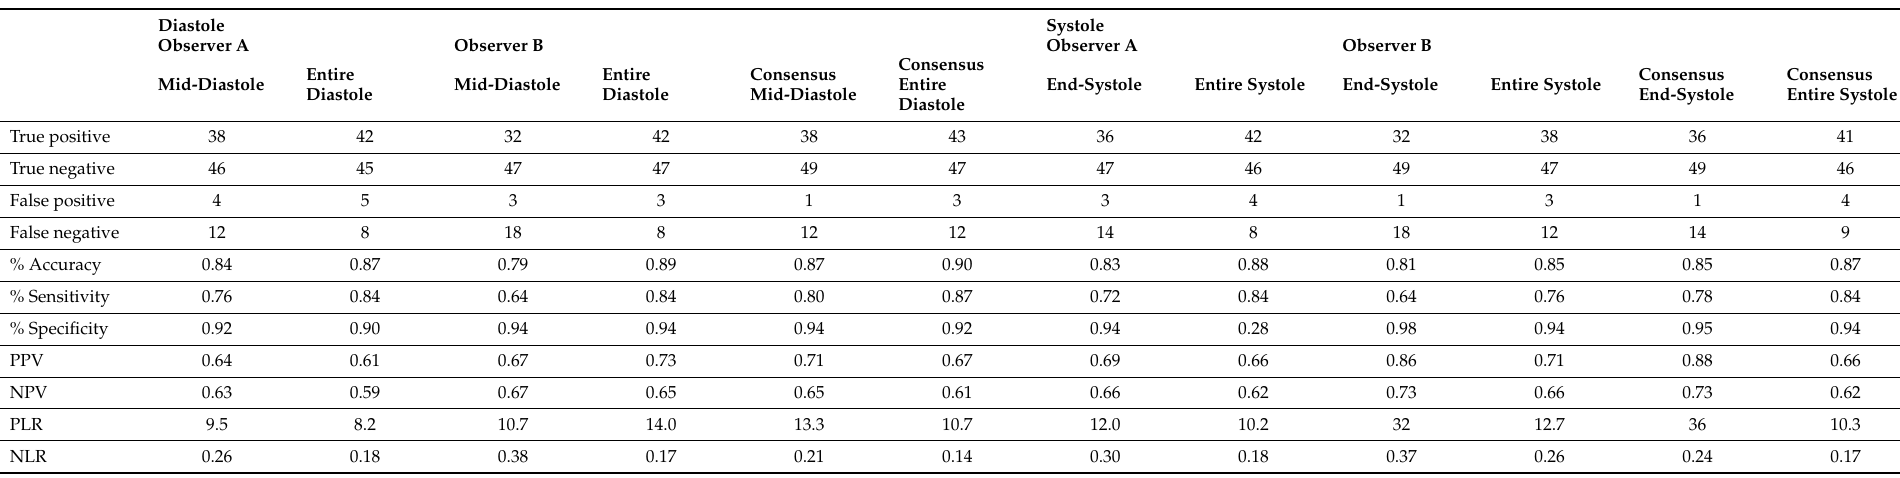
Table 2. Comparison of single observer diagnosis of HALT in different phases of the cardiac cycle with full cardiac cycle consensus